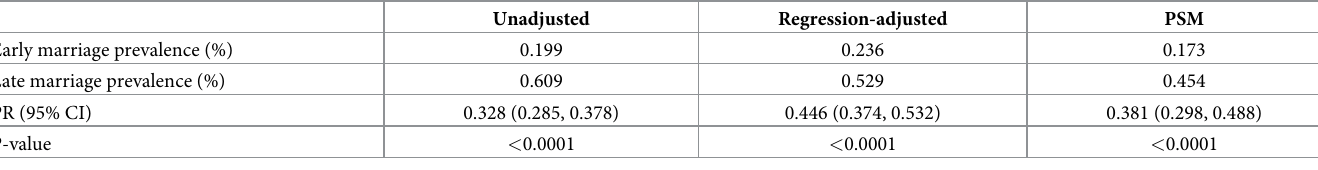
Table 2. Association of child marriage and completion of lower secondary